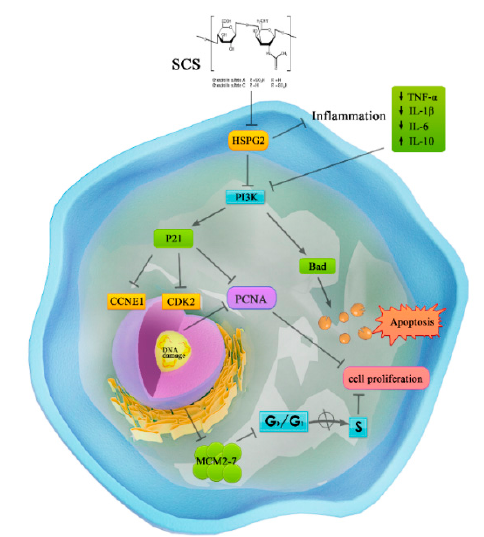
Figure 7. The potential mechanism of SCS-induced inhibition of colorectal cancer progression. Supplementary Materials: The following are available online at https://www.mdpi.com/article/10